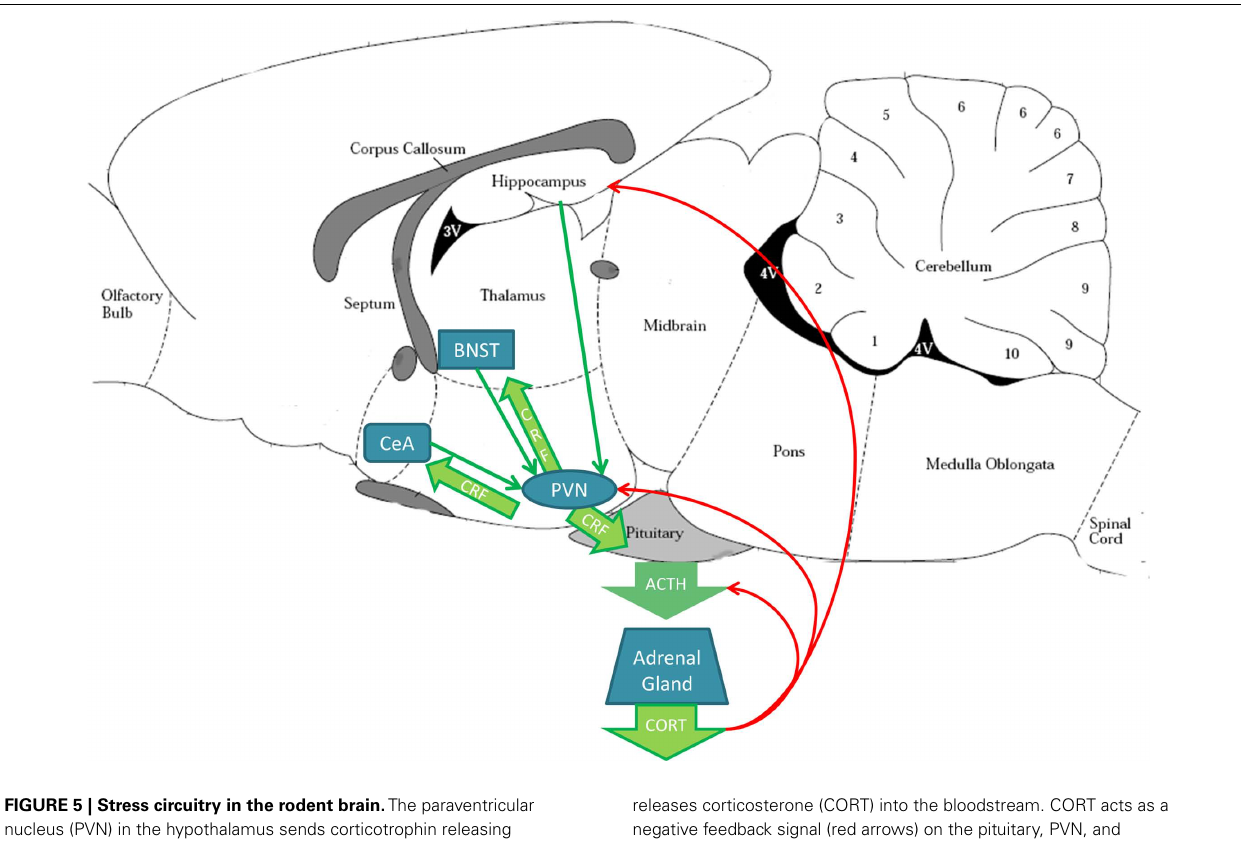
FIGURE 5 | Stress circuitry in the rodent brain. The paraventricular nucleus (PVN) in the hypothalamus sends corticotrophin releasing factor (CRF) projections (green arrows) to the central amygdala (CeA), bed nucleus of the stria terminalis (BNST), and the pituitary gland.The pituitary gland releases adrenocorticotrophic hormone (ACTH) into the blood stream that travels to the adrenal gland. Adrenal gland